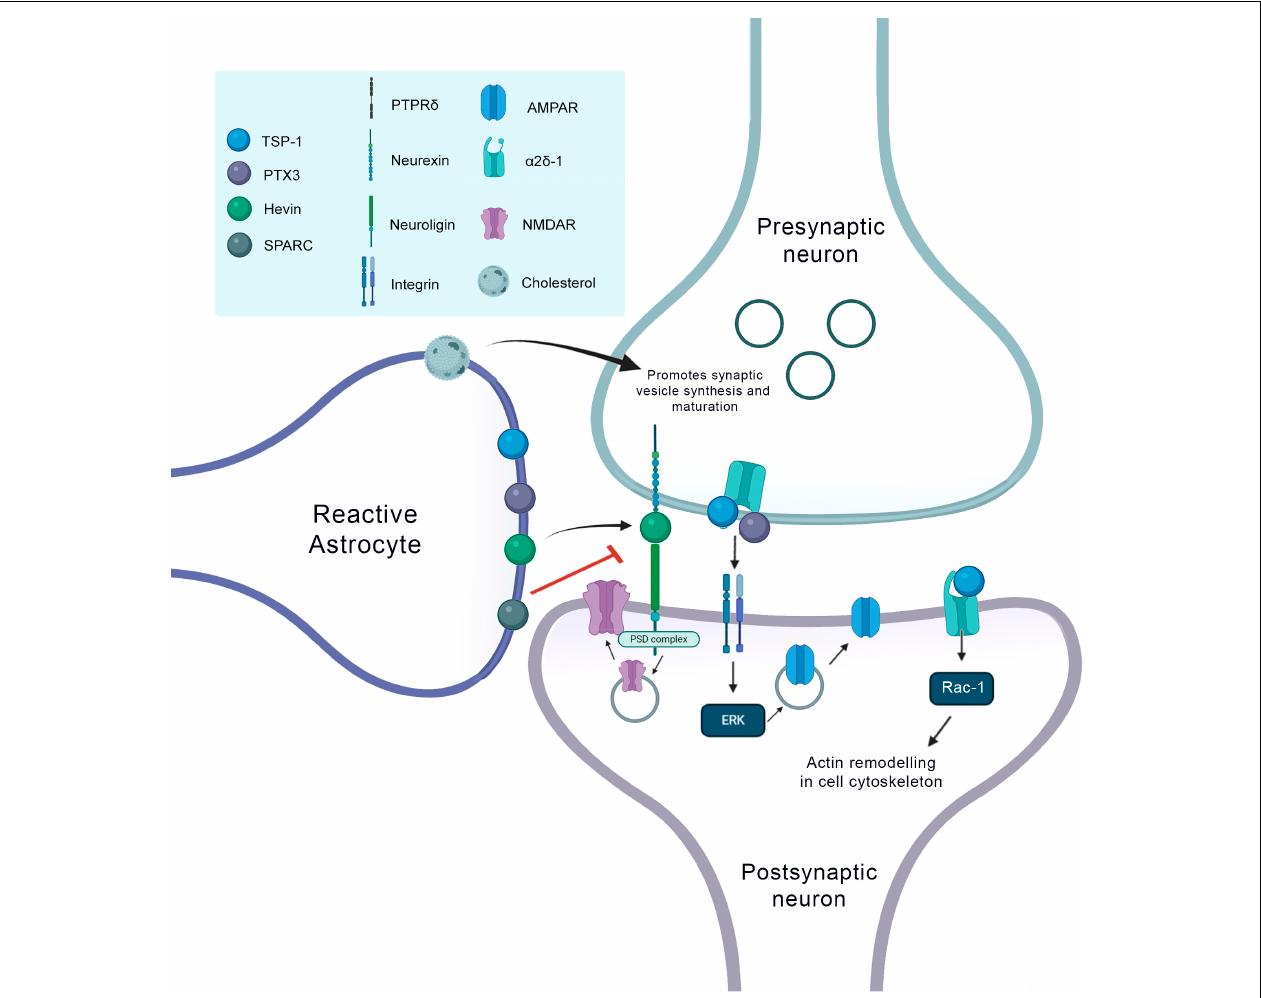
FIGURE 4 | Synaptogenic factors involved in neurorepair in the context of the CNS injury. At the presynaptic terminal, TSP1 and PTX3 bind to the α 2 δ 1 receptor. This binding of TSP at the presynaptic site increases the number of synapses, but they are silent, so the PTX3 molecule released together with TSP, promotes the functional maturation of these synapses by recruiting AMPA receptors. The binding of TSP to postsynaptic receptors, activates the Rac1 protein and stimulates actin remodeling to promote synaptogenesis. Hevin makes the connection between neurexin and neuroligin and thus increases the recruitment of the PSD95 and NMDAR subunits. Hevin’s effect is antagonized by SPARC. Cholesterol increases presynaptic differentiation promoting the synthesis and maturation of synaptic